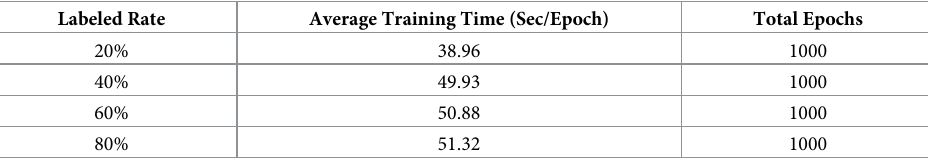
Table 2. Average training time at different labeled